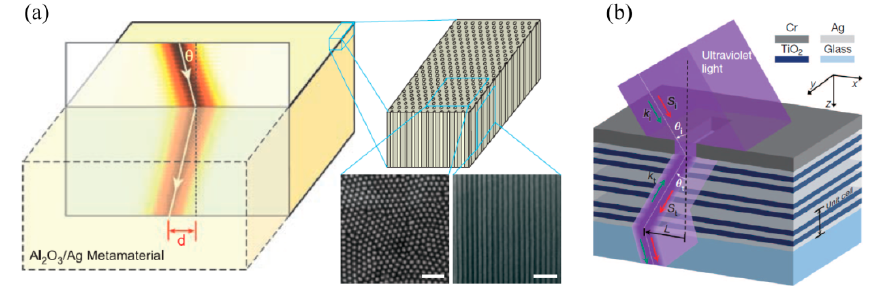
Figure 23. Optical bulk negative refraction index lens by ( a ) Silver nanowire metamaterials and ( b ) Stacked plasmonic waveguides metamaterial. Reproduced from: (a), [99], Copyright © 2008, AAAS; (b), [39], Copyright © 2013, NPG.